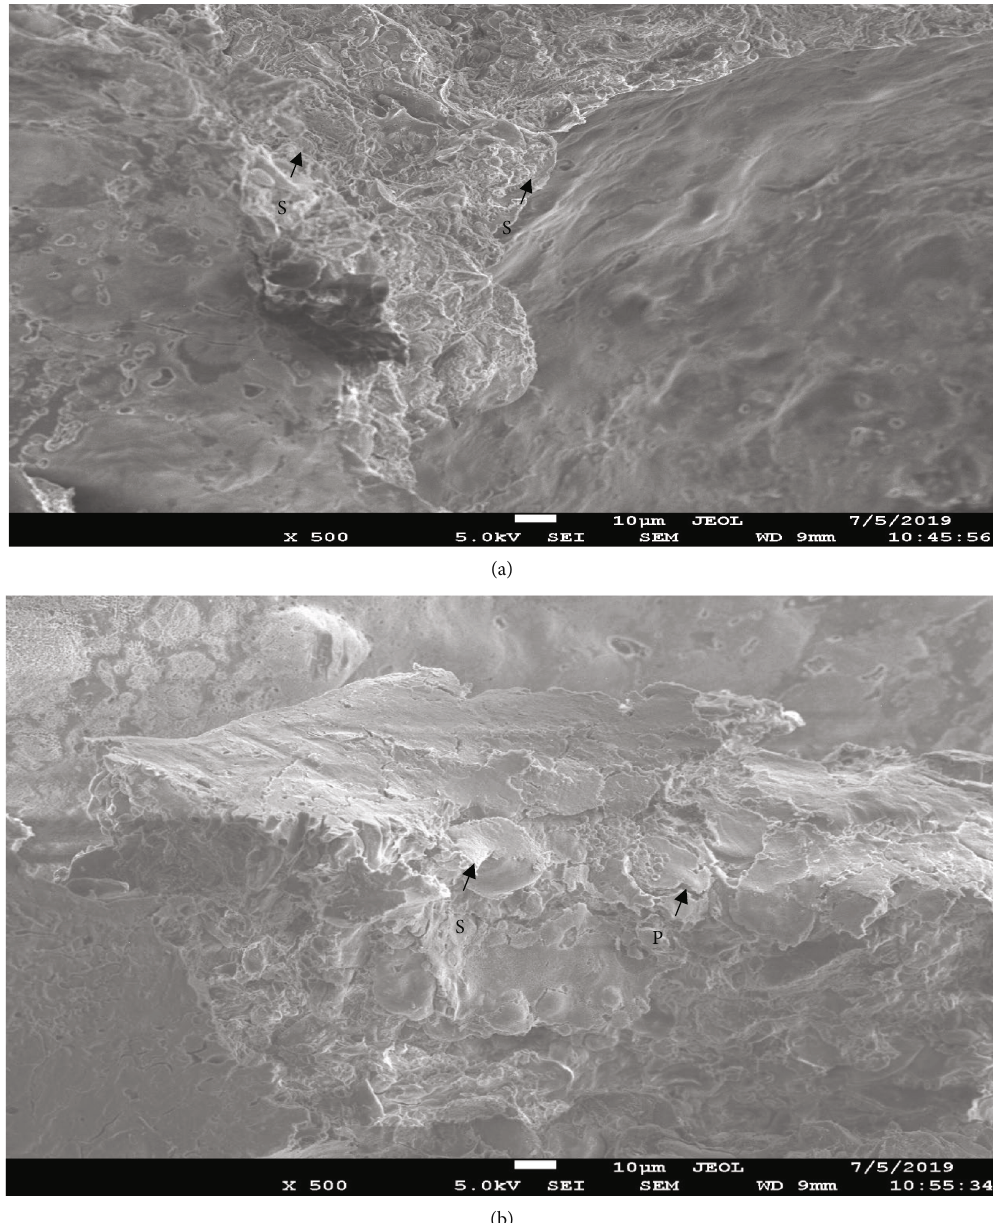
Figure 7: Photo study experienced crumb samples prepared using scanning electron microscopy (total magni fi cation is × 500). Grain matrix: (a) control and (b) with the addition of crushed dry turmeric root (S: corn starch; P: protein